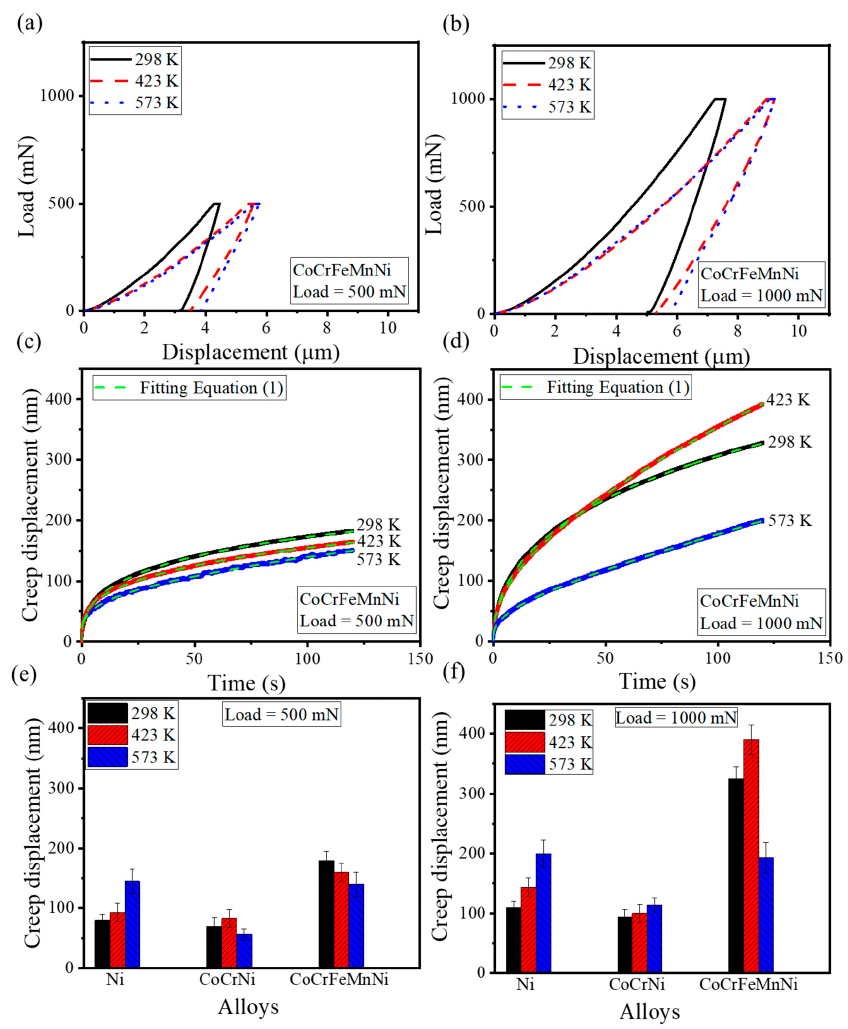
Figure 2. Typical load-displacement plot after nano-indentation creep tests for CoCrFeMnNi alloy as a function of temperature under applied load of ( a ) 500 mN and ( b ) 1000 mN. Creep displacement versus hold time for CoCrFeMnNi alloy at different temperatures under load of ( c ) 500 mN and ( d ) 1000 mN. Total creep displacement as a function of temperature for Ni, CoCrNi, and CoCrFeMnNi alloys at ( e ) 500 mN and ( f ) 1000 mN.